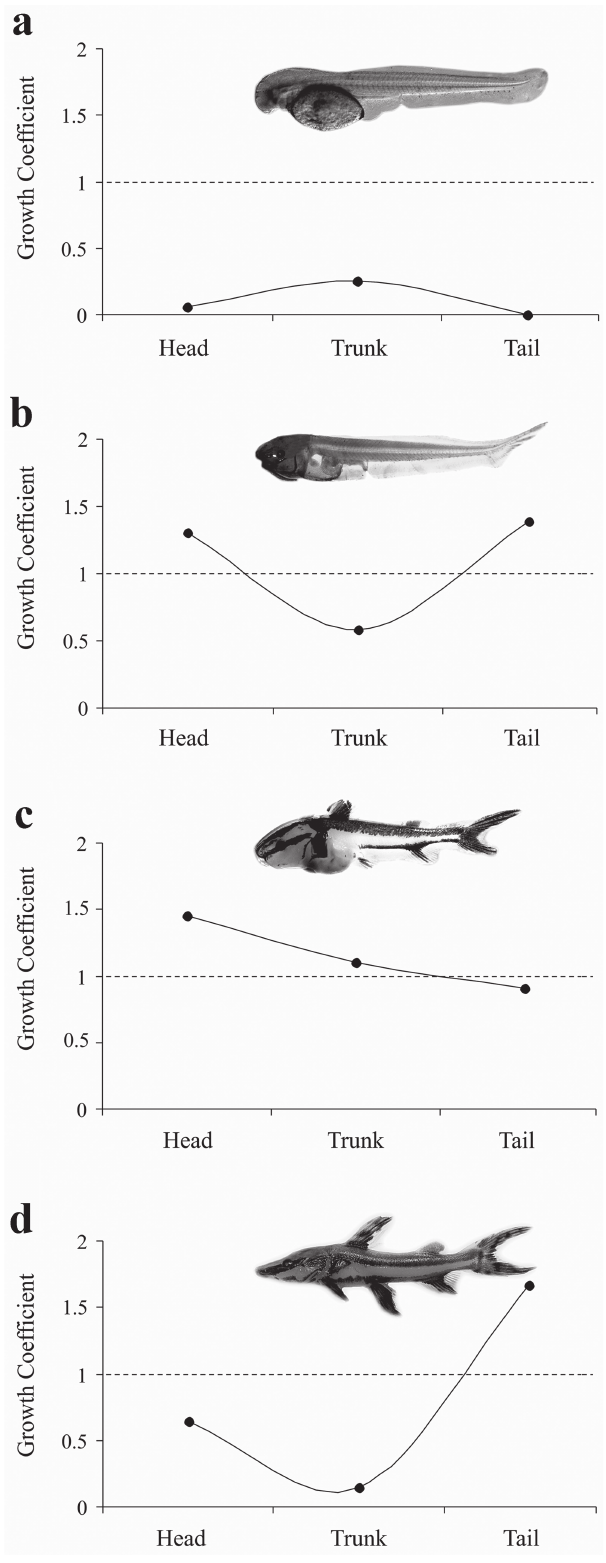
Fig. 7. Growth coefficients of the head, trunk, and tail during the development of Pseudoplatystoma reticulatum . Larvae in preflexion (a), flexion (b), and postflexion (c) stages; and juvenile